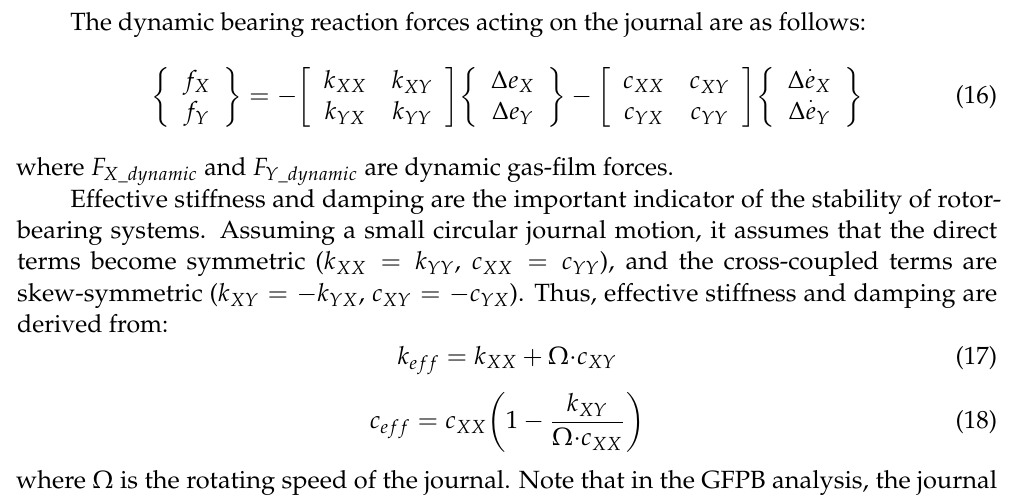
Effective stiffness Effective damping